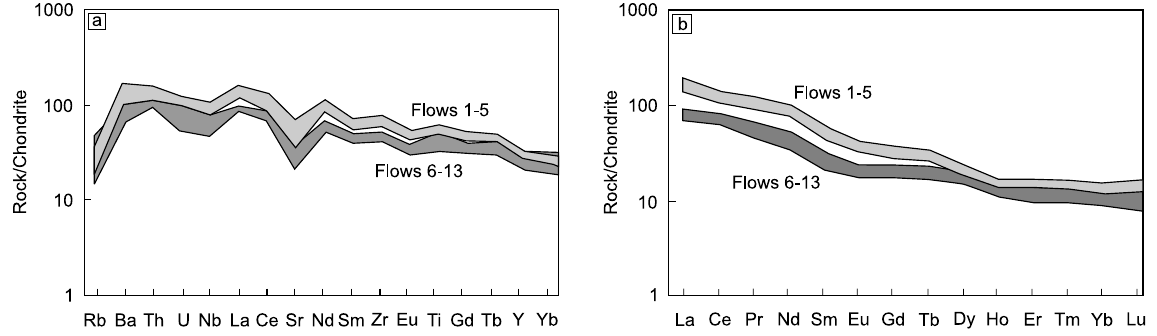
Fig. 9 – Basalt compositions from the Vista Alegre region. Primitive mantle-normalized trace element patterns in (a) and chondrite-normalized REE patterns in (b) of flows 1–5 (light gray) and flows 6–13 (dark gray) basalts. Normalization values are from Sun and McDonough